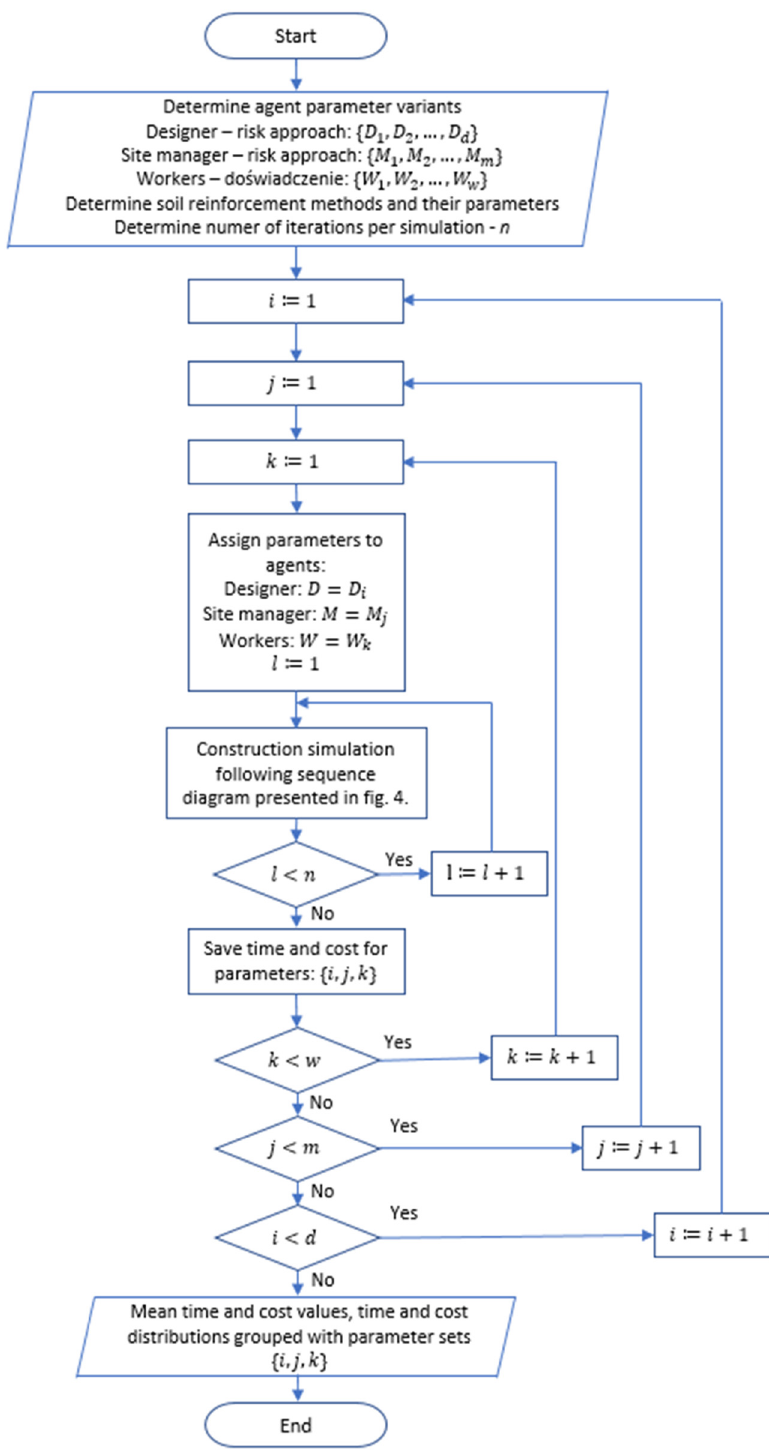
Figure 6: Block diagram of the simulation algorithm used to analyse the